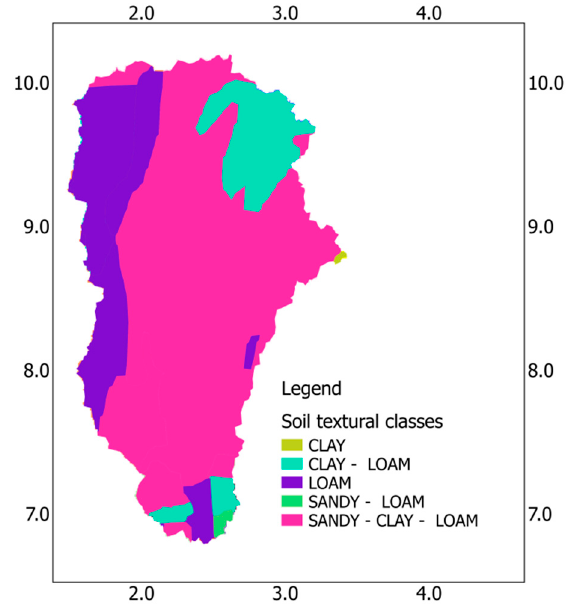
Figure 3. Ouémé catchment soil textural classes map. Figure 3. Ou é m é catchment soil textural classes